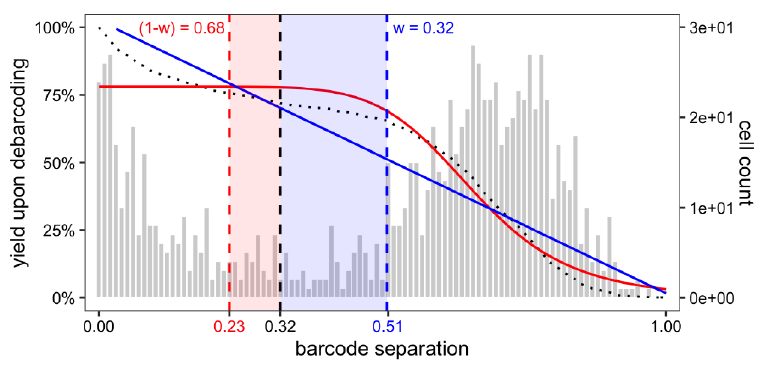
Figure 19. Schematic description of automated separation cutoff estimation. Bar graphs represent the distribution of cells relative to the barcode distance, dotted line scorresponds to yield upon debarcoding as a function of the applied separation cutoff. The yield curve is fitted with a linear regression (blue) and a three parameter log- logistic function (red). The final cutoff estimate (black dashed line) is defined as the mean of estimates derived from both fits, weighted with the goodness of the respective